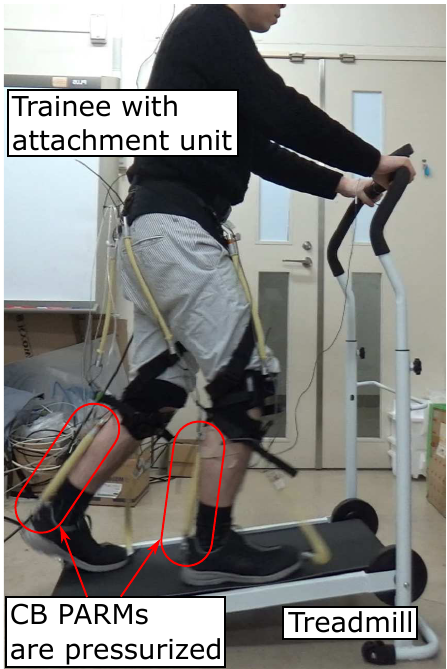
Figure 7. Walking experiments to determine the proper pressure in the CB PARMs. The trainee wearing the gait assistive suit walks on the treadmill with the pressurized CB